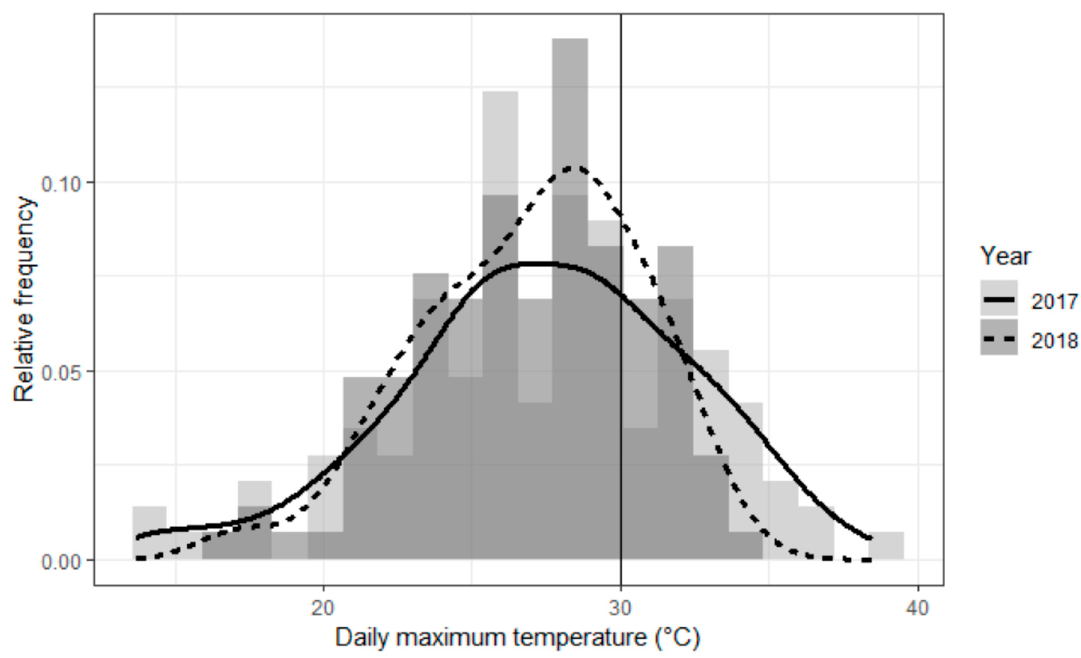
Figure9. DistributionofdailymaximumairtemperaturesobservedattheKeszthelyAgrometeorological Figure 9. Distribution of daily maximum air temperatures observed at the Keszthely Research Station, between the summers of 2017 and 2018 (from June to August). Vertical line is the Agrometeorological Research Station, between the summers of 2017 and 2018 (from June to August). upper bound of the optimum temperature range of Vertical line is the upper bound of the optimum temperature range of soybean.